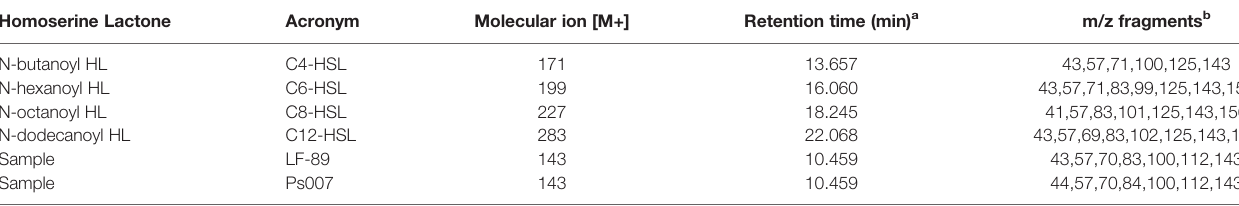
TABLE 1 | Experimental retention times and m/z fragments detected for standards AHLs molecules and samples analyzed. Homoserine